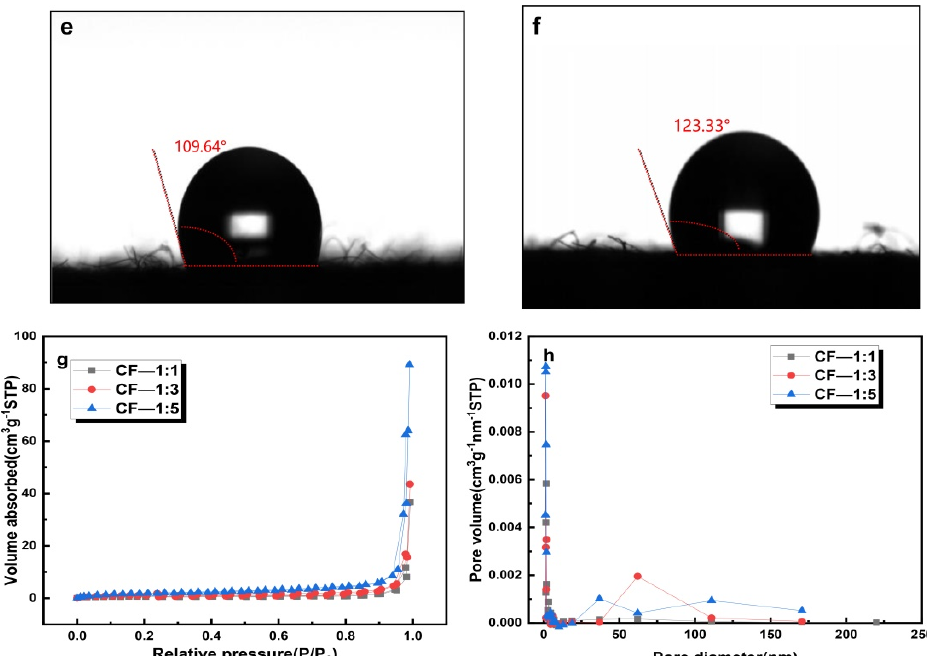
Figure 6. Morphological changes of modified CF are as follows: ( a ) low magnification and ( b ) high magnification SEM images of RCF, ( c ) low-power and ( d ) high—power SEM images of modified CF, ( e ) Contact angle of the original CF electrode, ( f ) Contact angle of the modified CF electrode, ( g ) pore size distribution, and ( h ) N 2 adsorption/desorption isotherms.